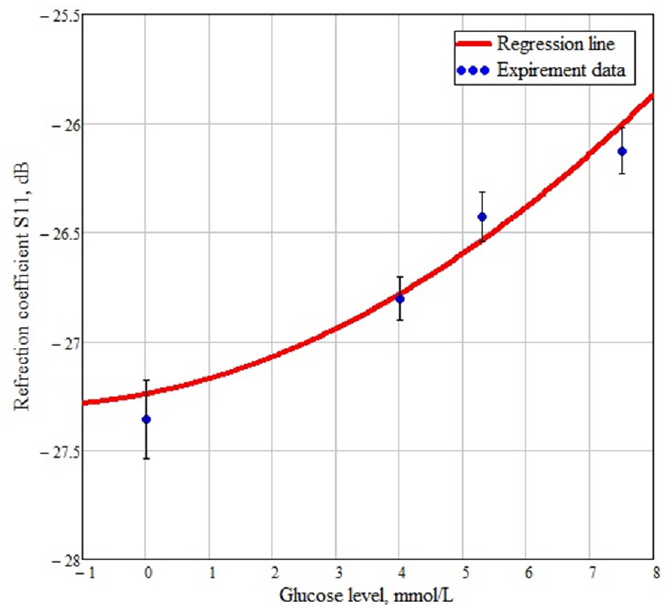
Figure 18. The dependence of the reflected signal on the concentration of glucose at a frequency of 3.5 GHz.